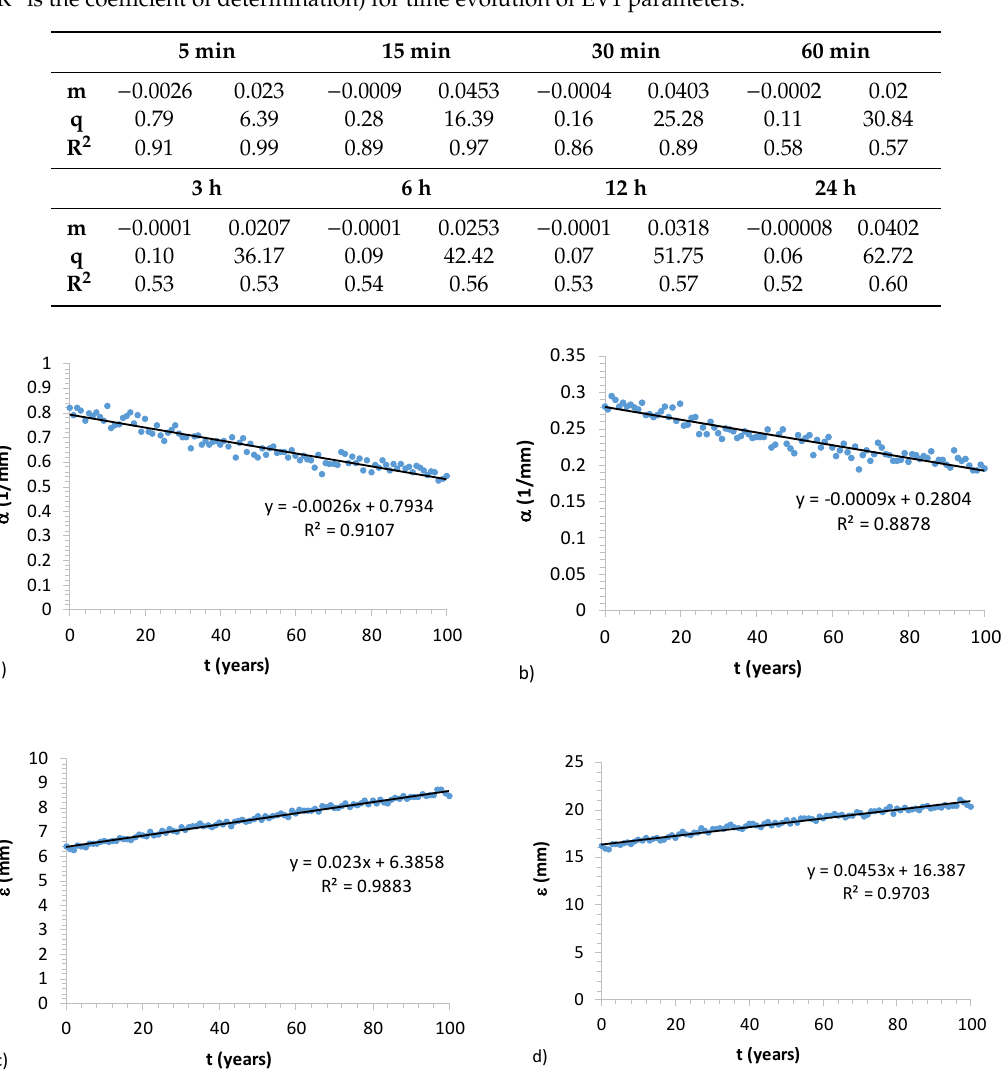
Table 6. Estimation of linear regression coefficients (m is the angular coefficient, q is the intercept and R 2 is the coefficient of determination) for time evolution of EV1 parameters.